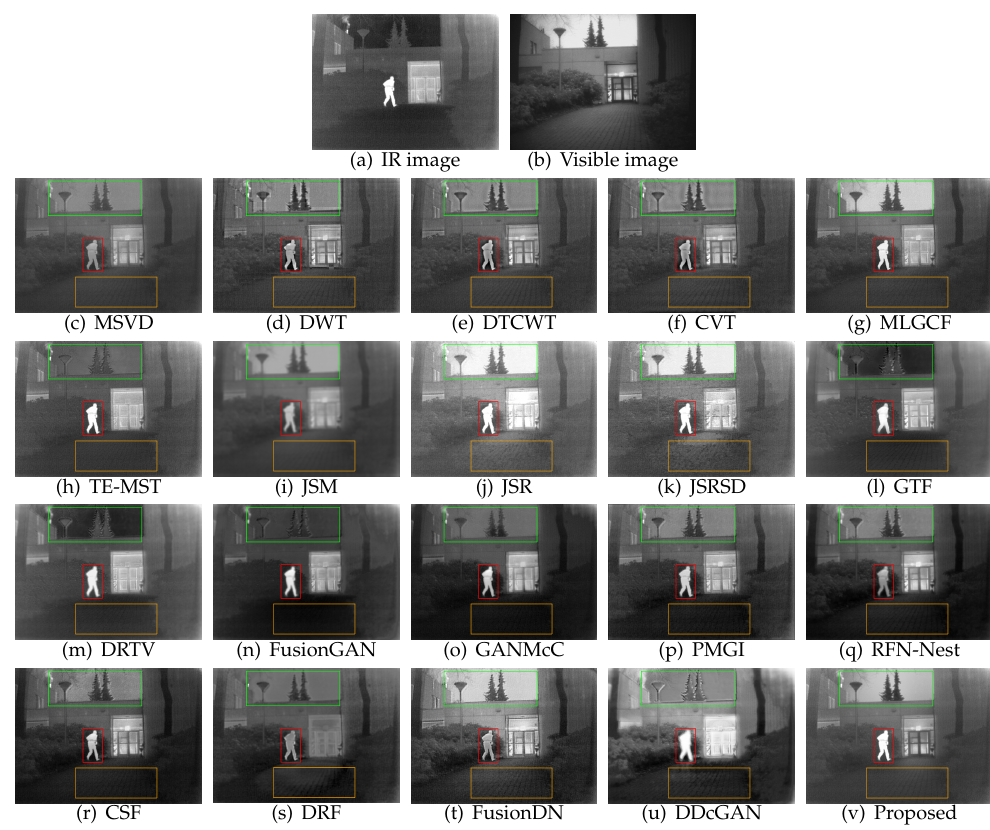
Figure 8. Fusion results of the “Kaptein” source